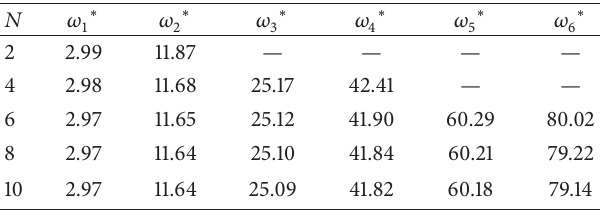
Table 4: Effect of model number 𝑁 on natural frequencies ( Ω ∗ = 0 and 𝜃 = 30 ∘